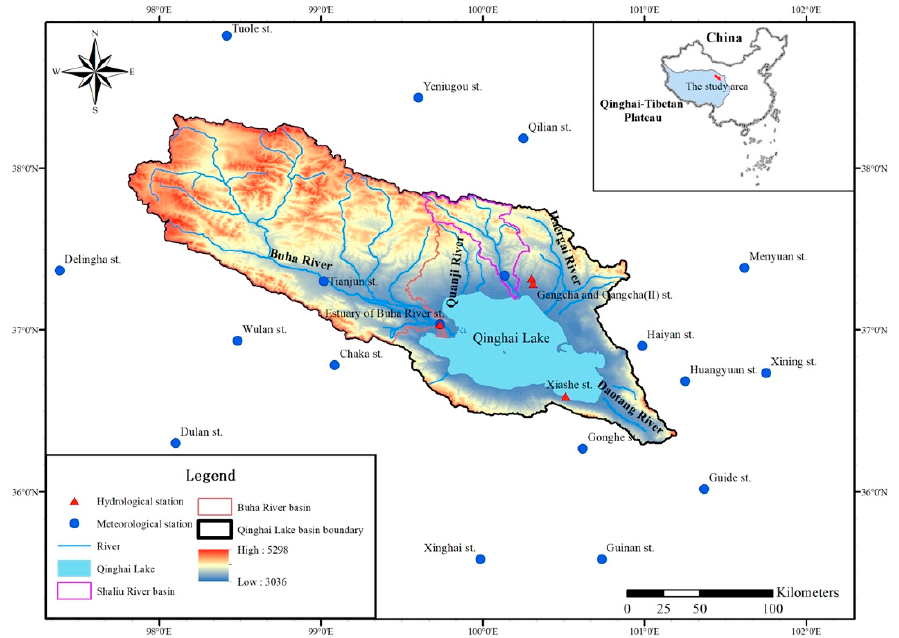
Figure 1. The location of Qinghai Lake basin in China (top right corner), physical characteristics of Qinghai Lake in Qinghai Lake basin (centre) and the spatial distribution of the hydrological stations (red triangles) and meteorological stations (blue dots).